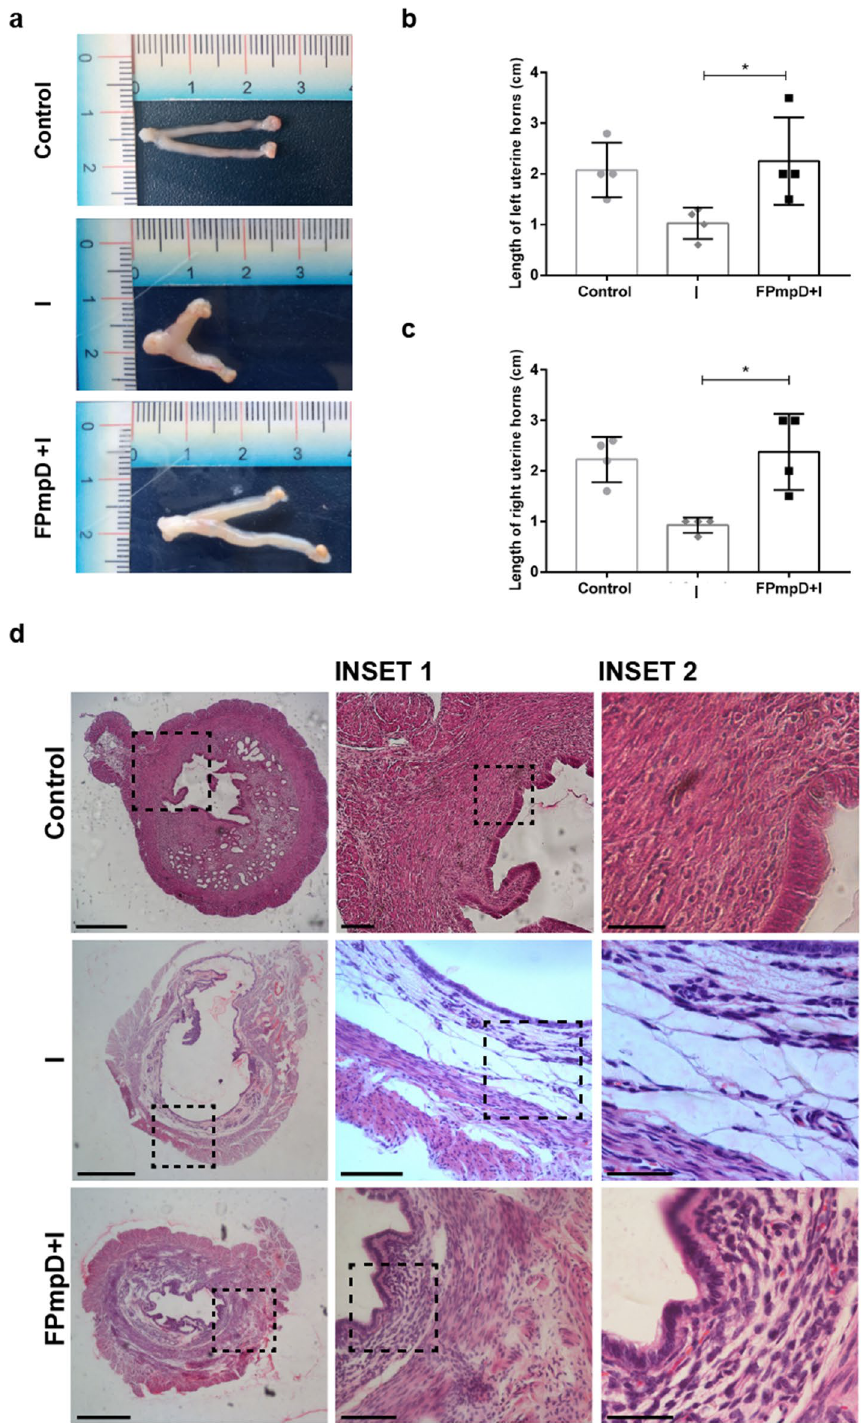
Figure 7. Morphological and Histological analysis of uterine horns. ( a ) Representative images of uteri from non-vaccinated infected mouse (I), FPmpD-vaccinated infected mouse (FPmpD + I), and non-vaccinated uninfected (Control) mice. ( b , c ) Length of left ( b ) and right ( c ) uterine horns. Each dot represents an individual mouse. Bars represent means ± SEM of each experimental group (Mann–Whitney; *p < 0.05). ( d ) Representative hematoxylin–eosin stained horn sections from non-vaccinated infected (I), FPmpD-vaccinated infected (FPmpD + I), and non-vaccinated uninfected (Control) mice on day 14 post Ct infection. Middle and right panels are magnifications of the insets of the selected areas of the corresponding